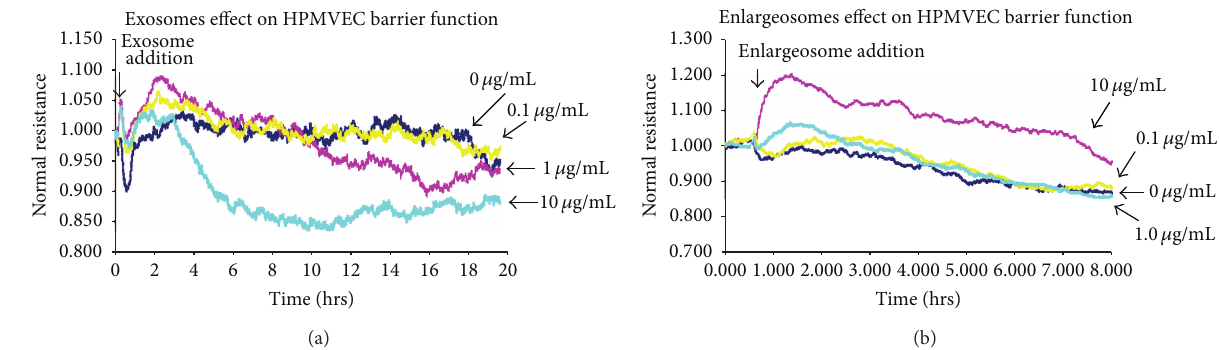
Figure 5: The effects of isolated LMW-HA and HMW-HA-induced EV on human EC barrier function. Panel (a): HPMVEC were plated on transendothelial electrical resistance (TER) electrodes, grown to confluence, and switched to serum-free media and 0, 0.1, 1, or 10 𝜇 g/mL isolated LMW-HA-induced exosomes were then added. Addition of isolated LMW-HA-induced exosomes to human EC monolayers promoted barrier disruption in a dose-dependent manner. Panel (b): HPMVEC were plated on transendothelial electrical resistance (TER) electrodes, grown to confluence, and switched to serum-free media and 0, 0.1, 1, or 10 𝜇 g/mL isolated HMW-HA-induced enlargeosomes were then added. Addition of isolated HMW-HA-induced enlargeosomes to human EC monolayers induces barrier enhancement in a dose- dependent